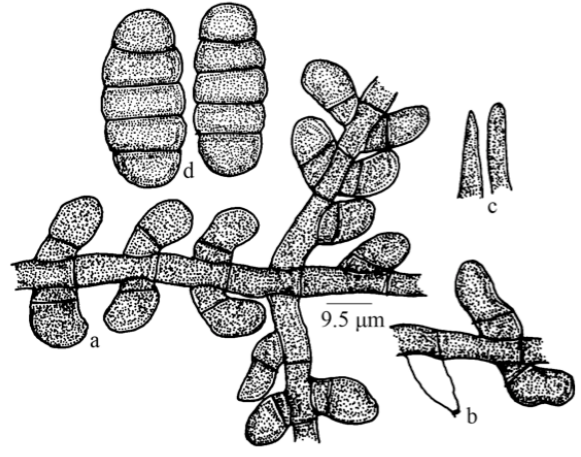
Figure 42. Meliola aphanamixidis a - Appressorium; b - Phialide; c - Apical portion of mycelial setae;